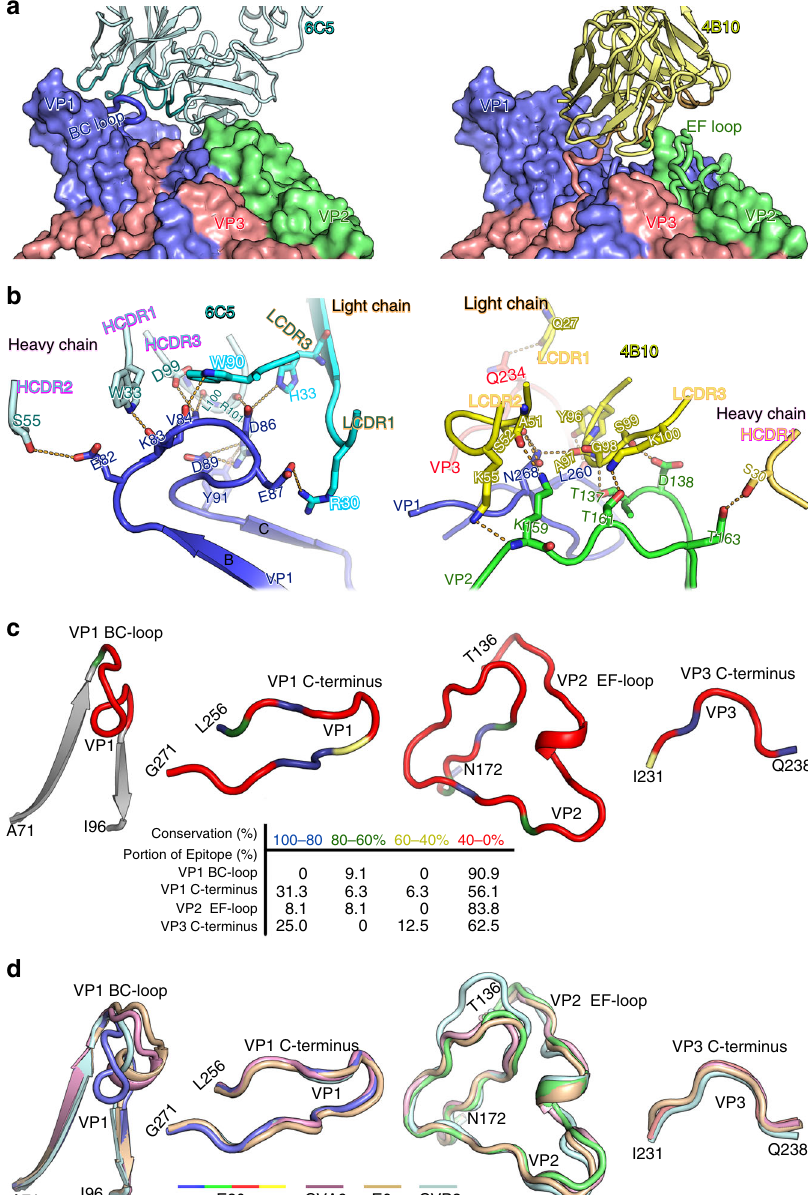
Fig. 4 Interactions between E30 and 6C5/4B10. a Platform for Fab (6C5, left and 4B10, right) binding with E30. Loops from E30 involved in interactions and the Fab parts are shown as cartoon, while the remaining parts of E30 are shown as surface. Also, the parts from 6C5 and 4B10 interacting with E30 are colored in dark cyan and dark yellow, respectively. The color scheme is as in Fig. 3c. b Binding interface between E30 and 6C5 (left), as well as E30 and 4B10 (right). Residues involved in the binding are shown as sticks and hydrogen bonds are shown as orange dashed lines. c Sequence conservation analysis. The loops from E30 that are involved in interactions between E30 and 6C5 (VP1 BC loop), as well as E30 and 4B10 (VP1 C-terminus, VP2 EF loop and VP3 C-terminus) are aligned with those of other enterovirus B members (E1, E6, E7, E11, E18, CVB3, CVA9), and colored according to sequence conservation as listed in the table below. d Structure conservation analysis. The same loops in 4c colored in the signature color scheme are superposed with their counterparts from E6 (colored in wheat), CVB3 (colored in pale cyan), and CVA9 (colored in pale